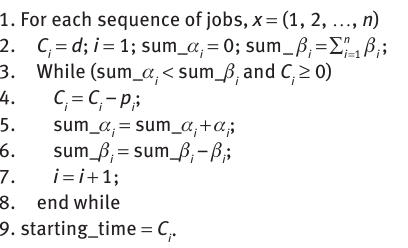
Algorithm 1: Computing starting time using property